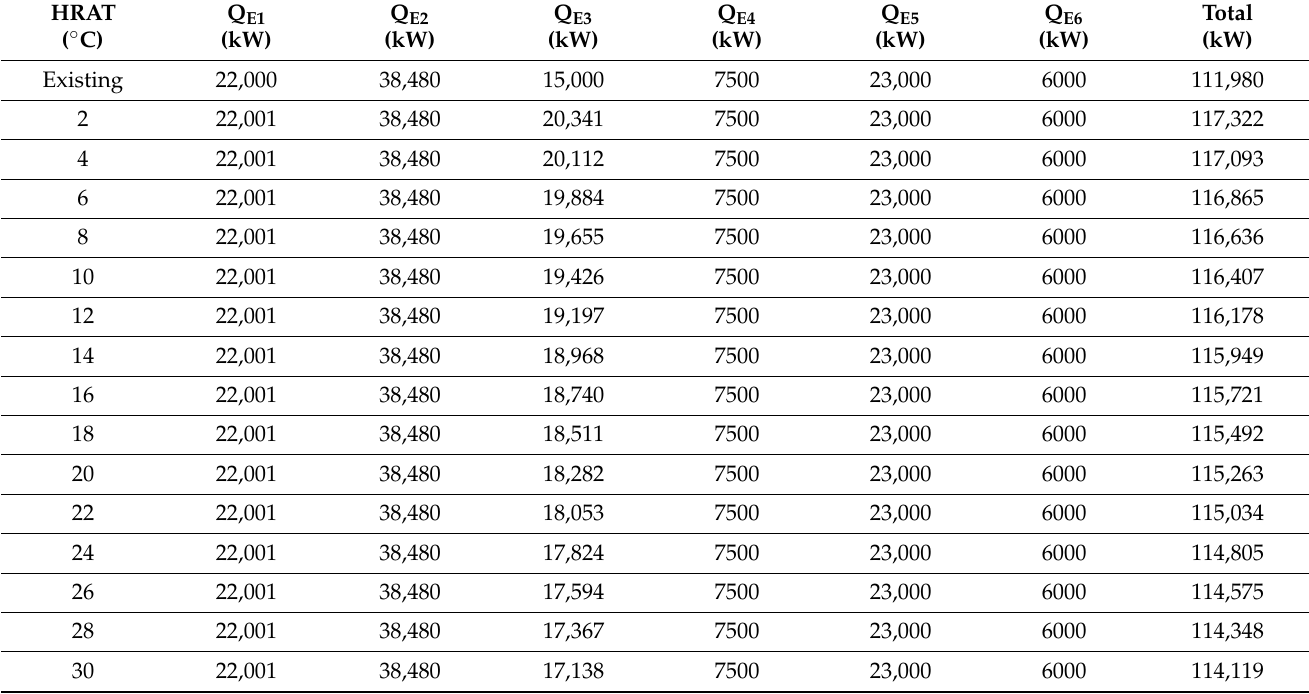
Table A1. Heat loads at different HRAT values for option